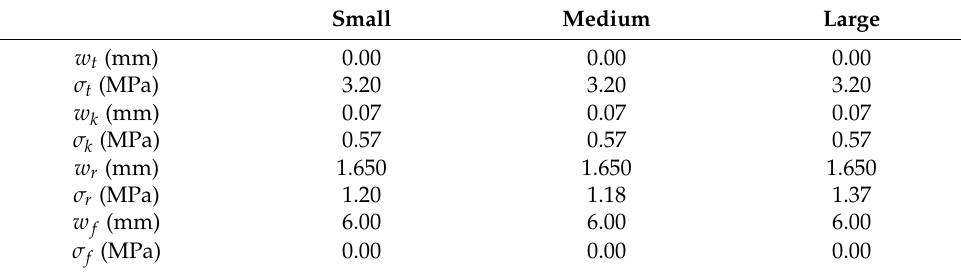
Table 6. Parameters of the softening diagrams for each specimen